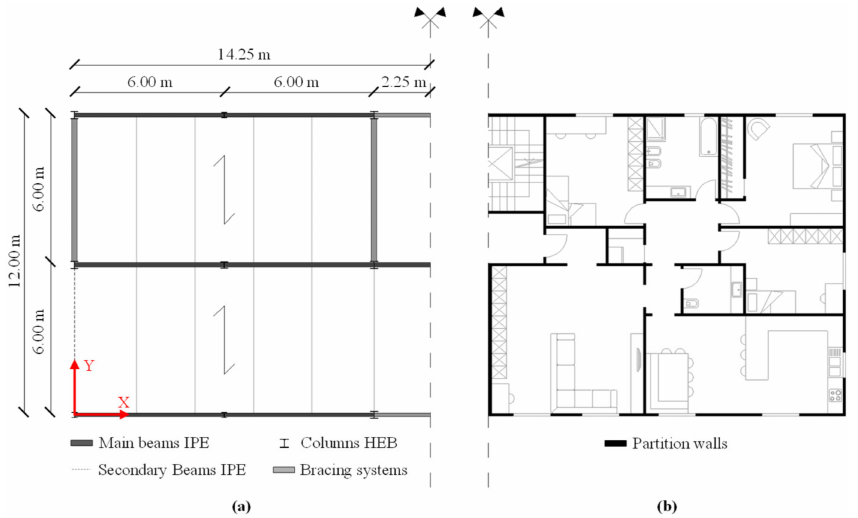
Figure 1. Structure arrangement ( a ) and apartments’ layout ( b ). Underneath the building’s envelope lies a modular steel frame stabilized by four and two X-diagonal bracing systems along shorter and longer directions. This three- dimensional frame has main beams laid along the building’s long-side direction, while secondaries are arranged along the shortest direction. The building has 5 and 2 spans along the main (X) and secondary (Y) façade directions. Figure 2a shows that the external walls are finished by cross-laminated timber (CLT) panels infilled into the frame, and floors are assembled using hybrid CLT-steel modular prefabricated